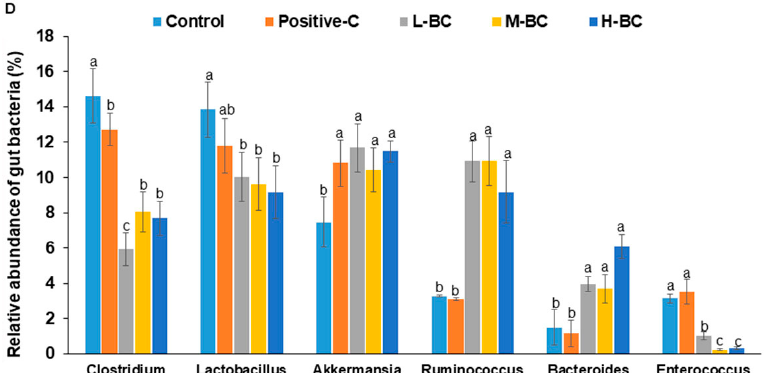
Figure 6. Profiles of the gut microbiome as determined by NGS analysis of bacterial DNA from the feces of the cecum. Partially pancreatectomized (Px) rats were fed a high-fat diet supplemented with 0% (control), 0.2% (L-BC; low dosage), 0.6% (M-BC; medium dosage), and 1.8% (H-BC; high dosage) blackcurrant extracts; 0.2% metformin (positive-C); plus 1.8%, 1.8%, 1.6%, 1.2%, 0%, and 1.6% indigestible dextrin. ( A ) α -diversity of gut microbiomes representing bacteria richness measured by Chao1 and Shannon index. ( B ) β -diversity of bacterial communities separated by principal coordinate analysis (PCoA). ( C , D ) Proportions of taxonomic assignments of major bacteria at the family ( C ) and genus ( D ) levels for gut microbiomes. Each bar/dot and error bar represents a mean and standard deviation, respectively ( n = 10). a,b,c,d Different letters on bars indicate significant differences among the groups at p <